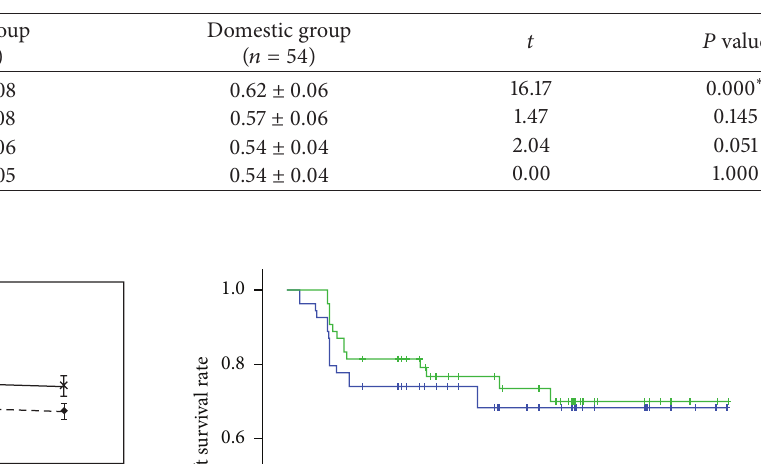
Table 5: Postoperative graft thickness (mm) in foreign and domestic donor groups at follow-up.